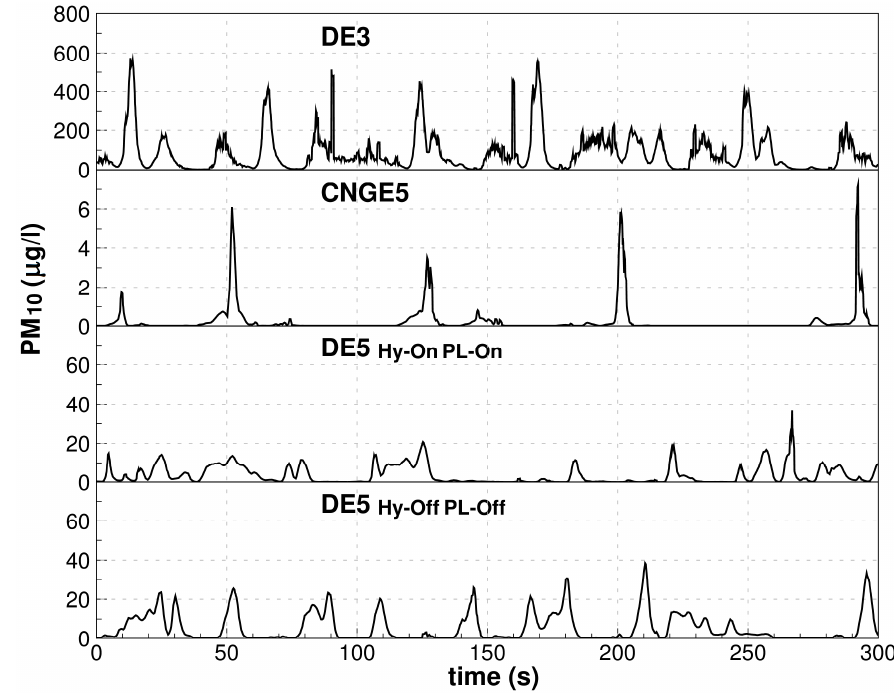
Figure 11. PM 10 mass emission vs time measured of the DE3 bus, CNGE5 bus, and DE5 bus in hybrid mode with power limiter on and in non-hybrid mode with power limiter off.